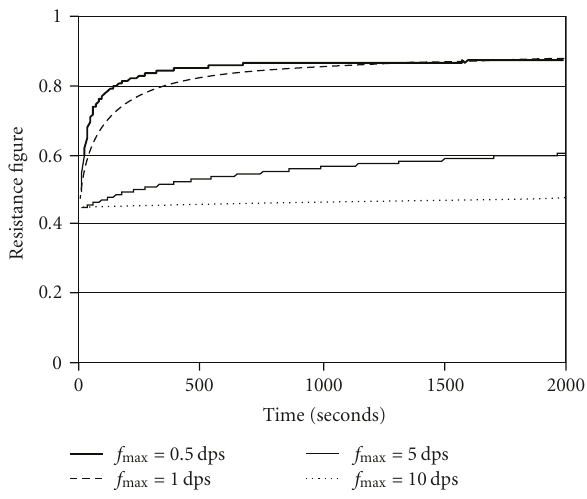
Figure 5: Studying the e ff ect of f max on the resistance figure considering FHI